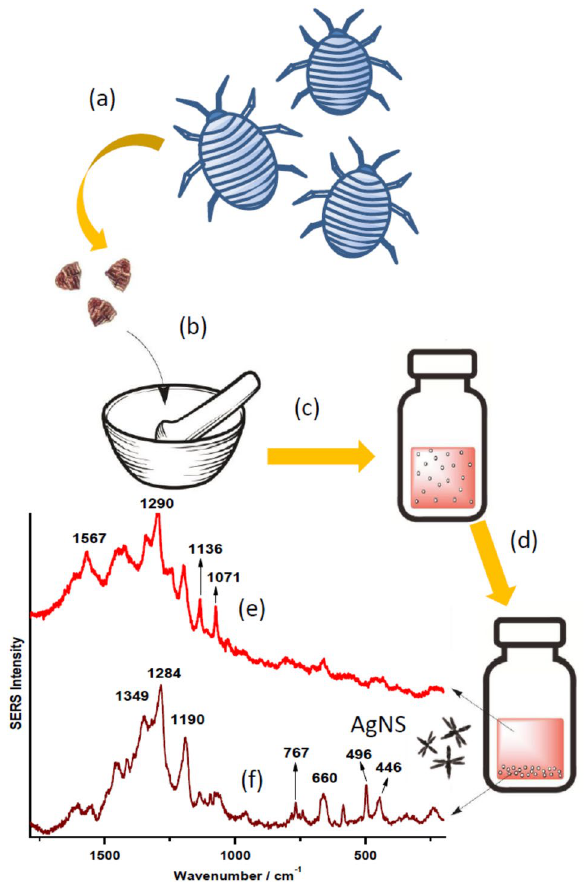
Figure 4. Extraction process followed to obtain the cochineal dye involving the following processes: drying ( a ), grinding ( b ), water suspension ( c ) and separation of supernatant and bottom residue ( d ). SERS spectrum obtained by using Ag nanostars and a sample obtained from the supernatant ( e ) and the bottom residue ( f